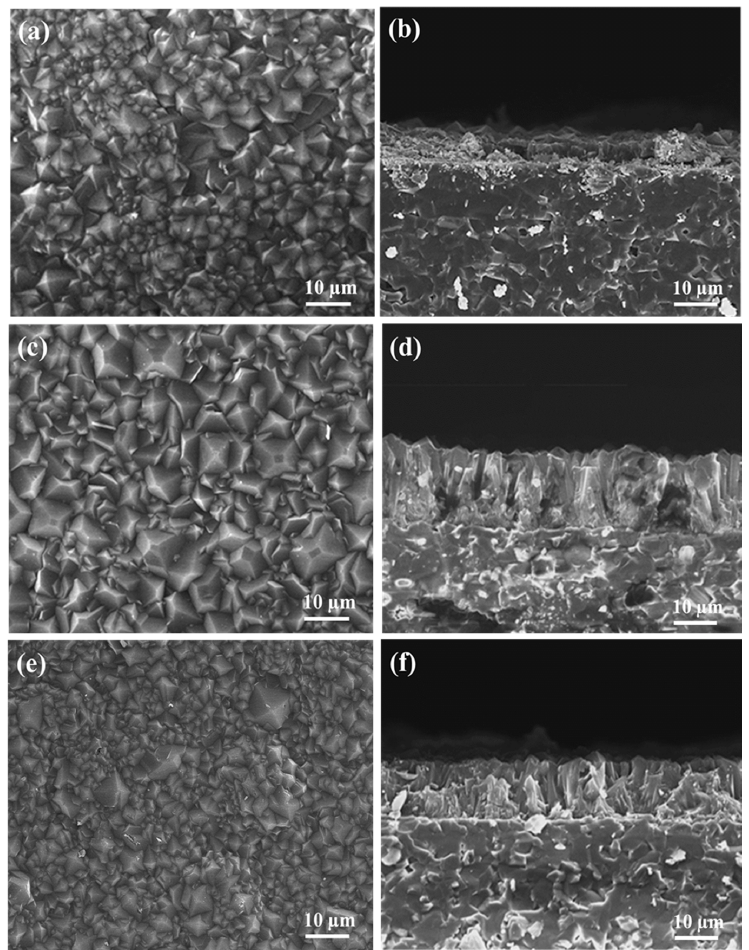
Figure 5. Top-view and cross-section SEM images of the Co44-ZIF-8 membrane with different sodium formate concentrations: 2.7 mmol ( a , b ), 5.4 mmol ( c , d ), and 10.8 mmol ( e , f ) at 100 °C for 2 h.